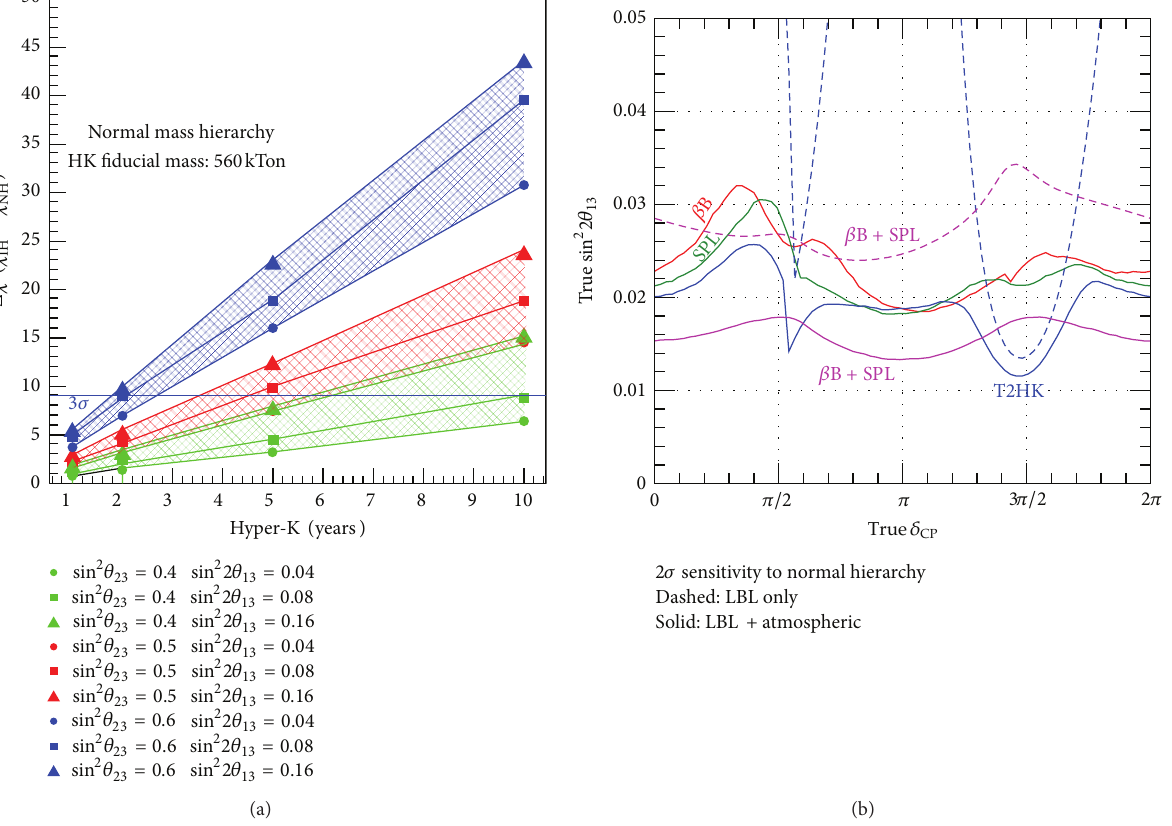
Figure 6: (a) Sensitivity to the neutrino mass hierarchy from Hyper Kamiokande atmospheric neutrino data. 𝜃 23 and 𝜃 13 are assumed to be known as indicated in the figure. Plot from [66]. (b) Sensitivity to the mass hierarchy at 2𝜎 from a combination of beams at relatively short baseline with 4.4Mtyr atmospheric neutrino data from a water Cerenkov detector. 𝛽 B and SPL refer to a beta-beam and a 4MW superbeam from CERN to Frejus (130km), respectively, whereas T2HK corresponds to a 4MW beam from JPARC to the HyperKamiokande detector (295 km). Dashed curves are data from beams only, and solid curves are for beams + atmospheric neutrinos. Figure is based on the results of